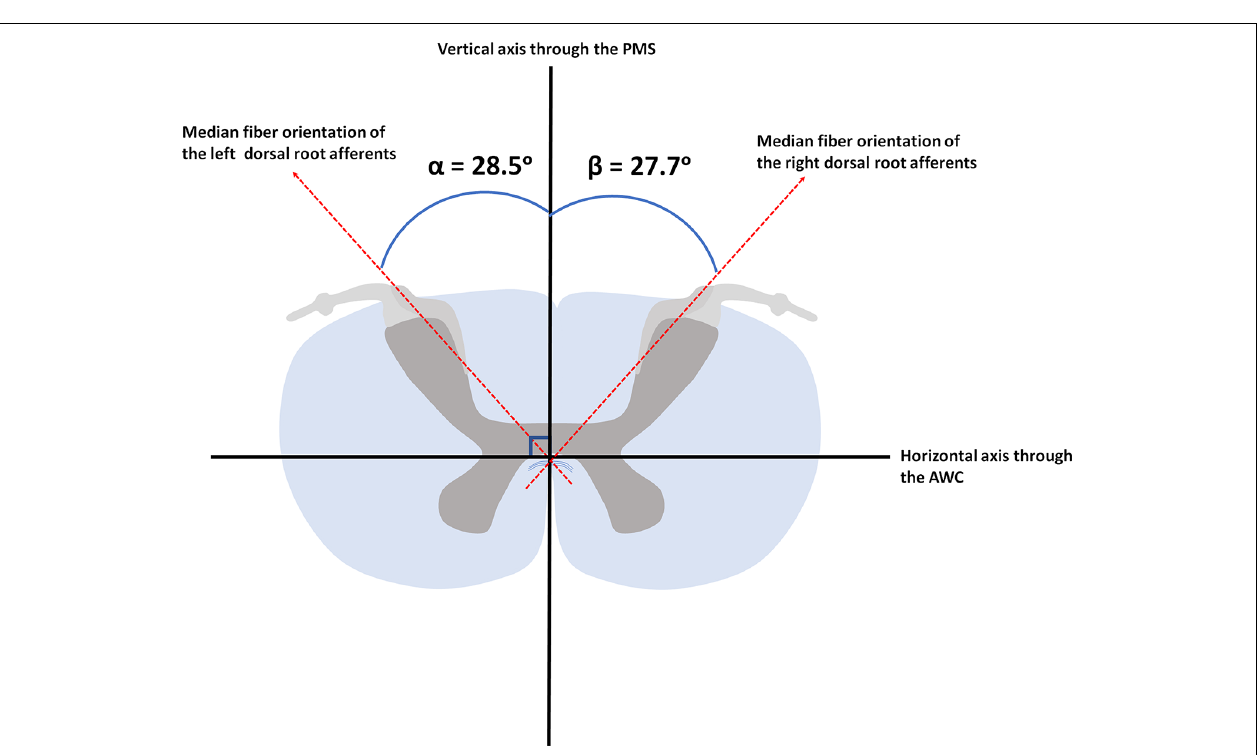
Frontiers in Neuroanatomy |